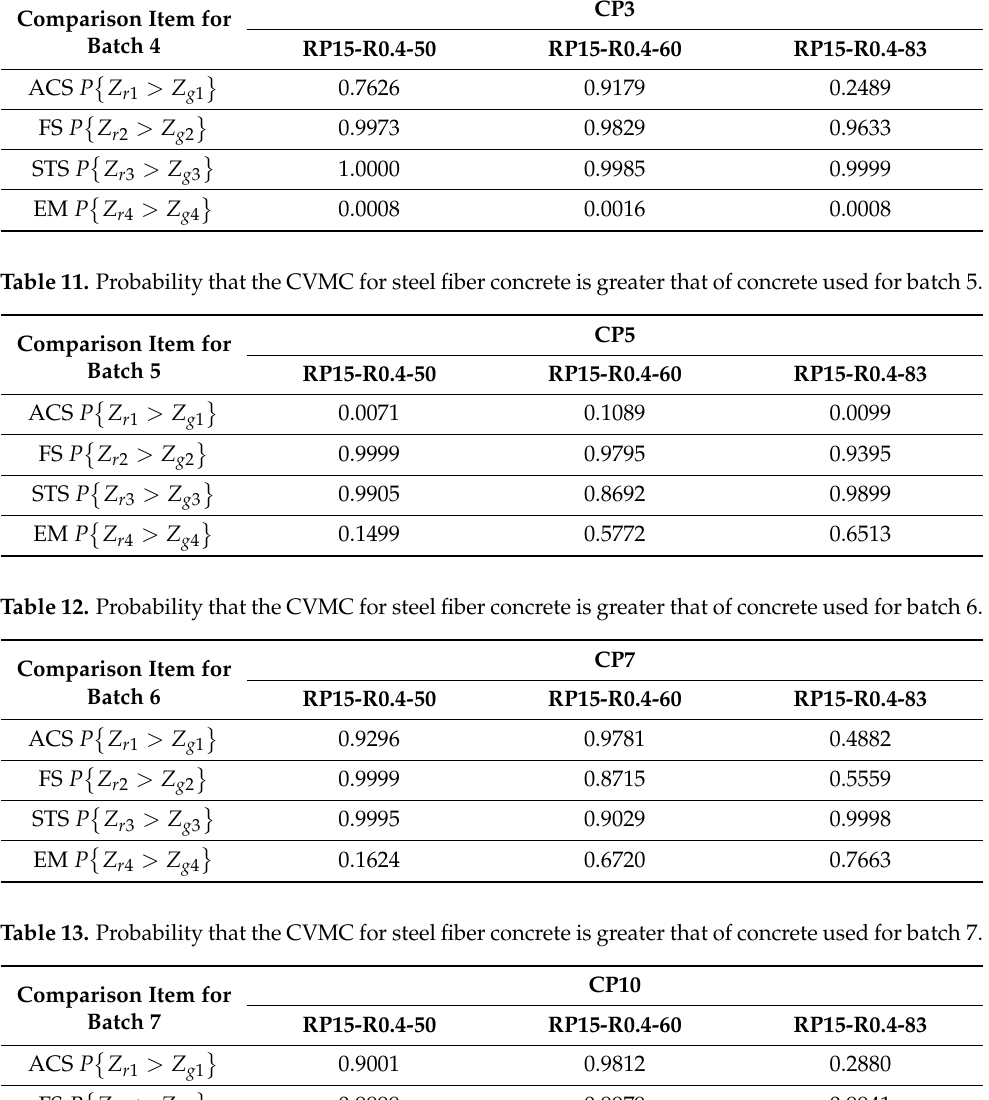
Table 10. Probability that the CVMC for steel fiber concrete is greater that of concrete used for batch 4. Comparison Item for